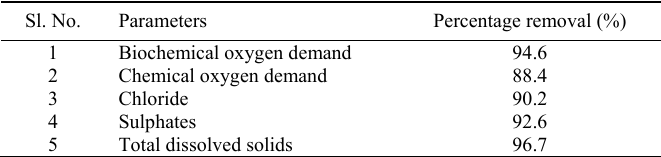
Table 4: Percentage removal of associated parameters from electroplating industry wastewater using bamboo activated carbon Sl. No.